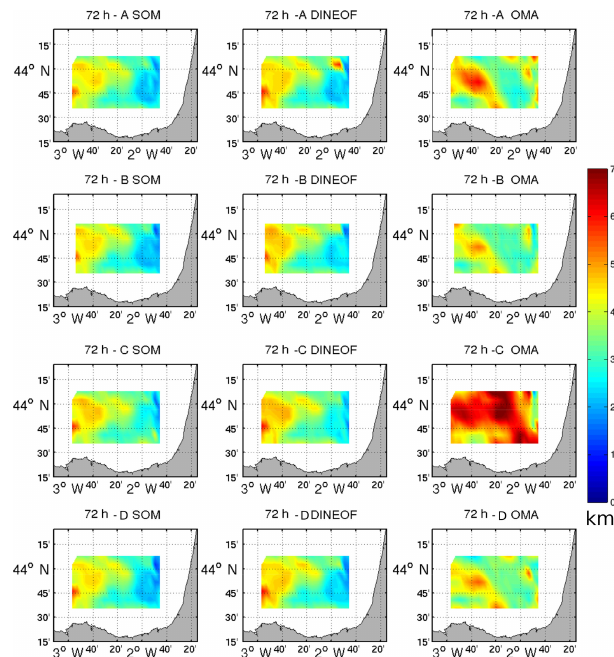
Figure 8. Time average of the separation distance between trajec- tories computed from the filled HFR using the three methodologies and reference HFR velocities initiated in the same